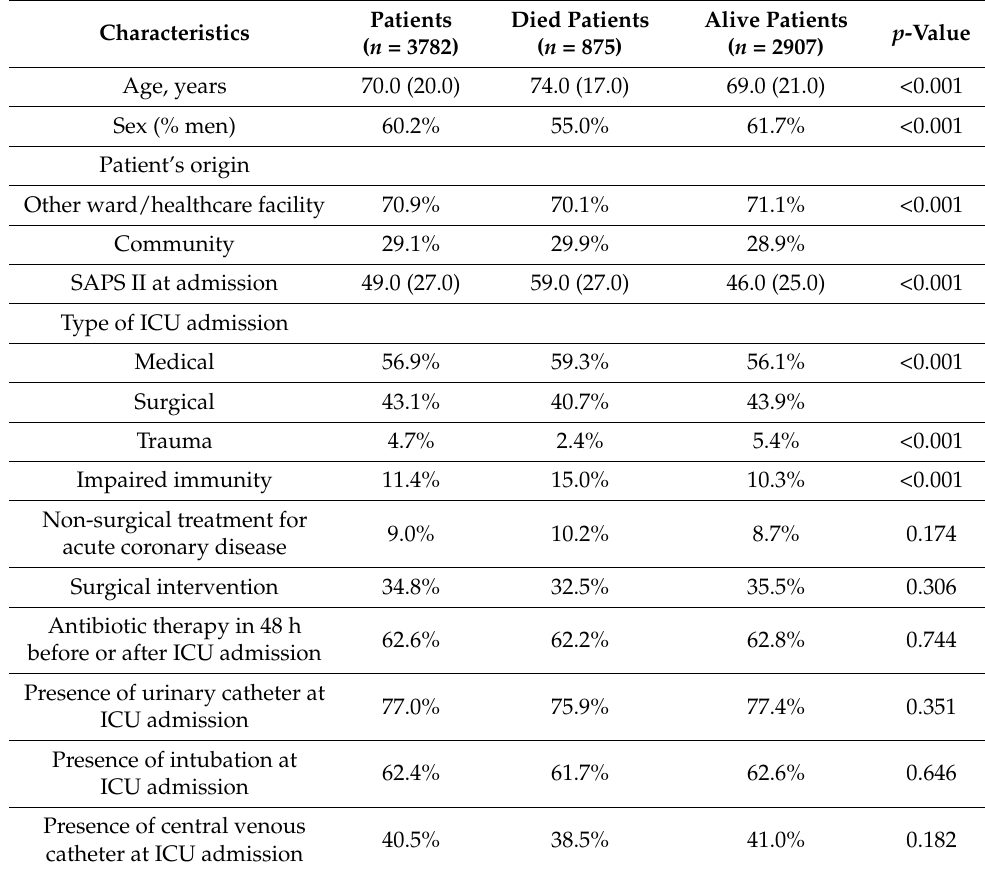
Table 1. Characteristics of patients with complete data according to their outcome status.